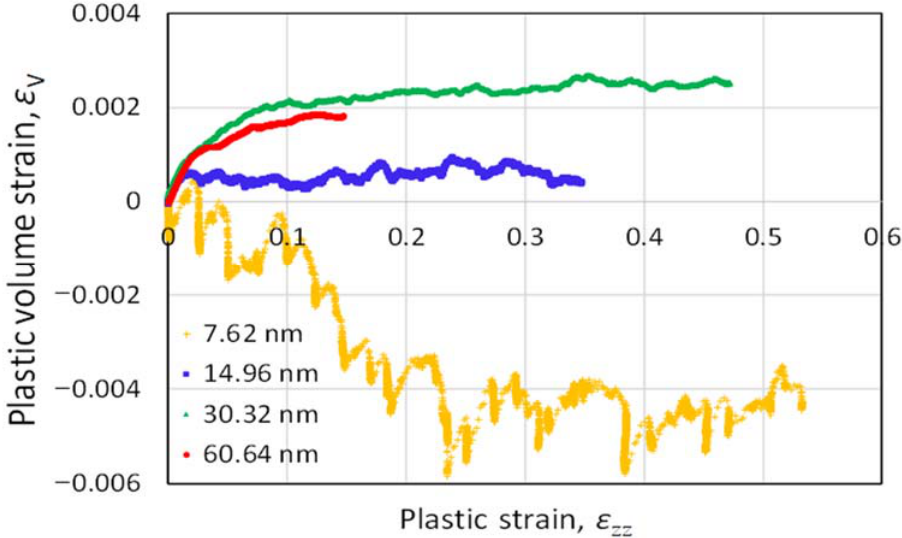
Figure 2. Plastic volume strain as a function of the plastic elongation (logarithmic strains) of the four samples (their initial axial lengths are indicated in the figure).